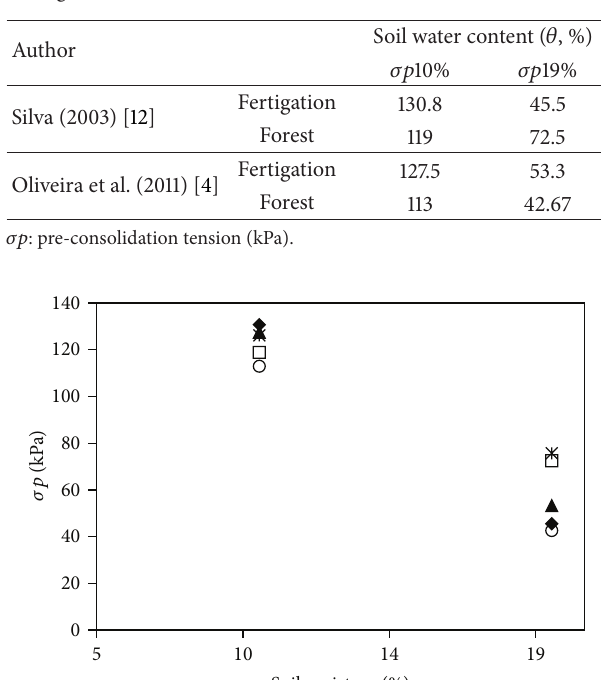
Table 3: Preconsolidation tension (kPa) of Ultisol under different managements and soil moisture content.